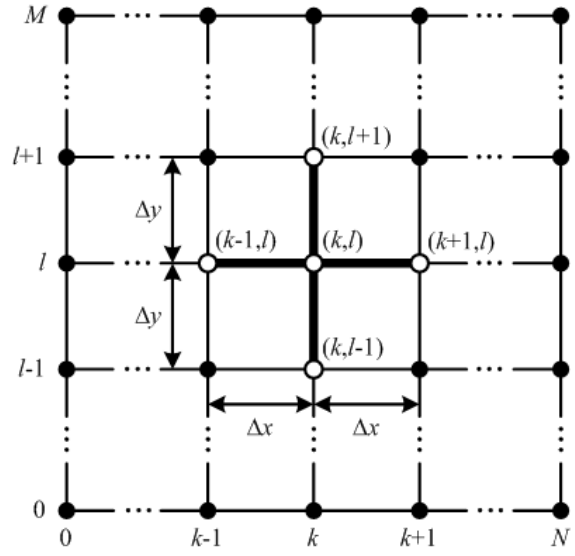
Figure 3: A finite difference